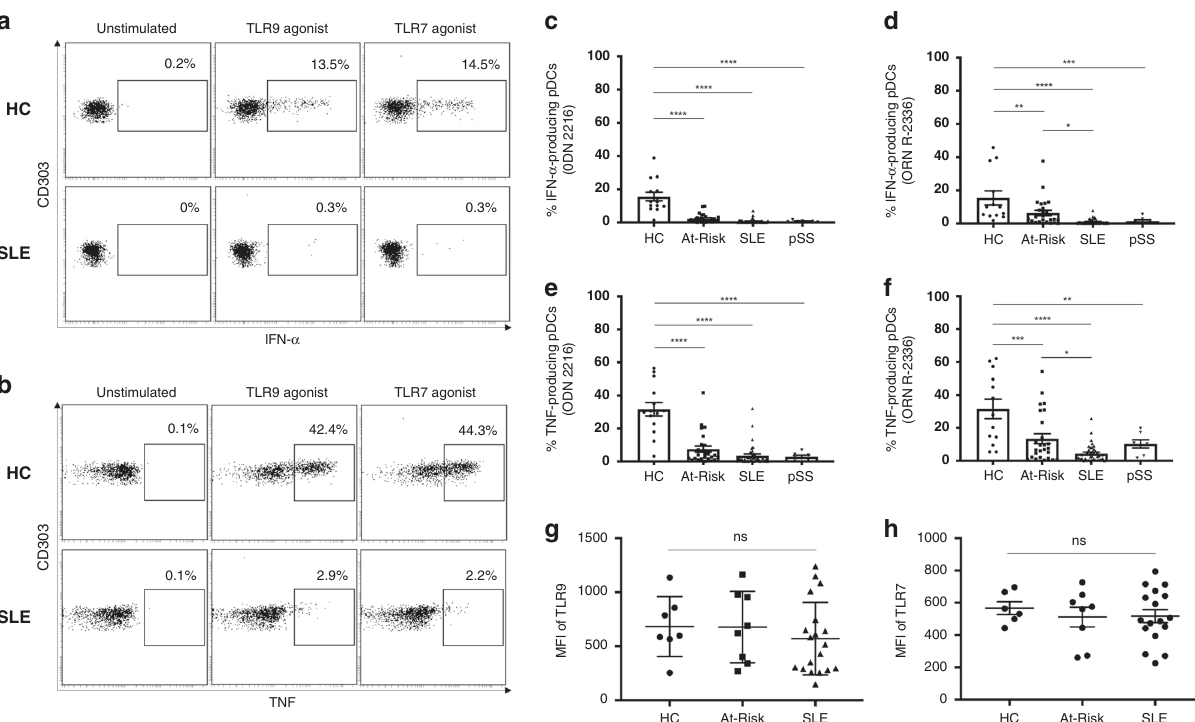
Fig. 2 TLR-stimulated pDCs produce less IFN- α and TNF in autoimmunity. a , b Freshly isolated PBMCs were cultured in the absence or presence of TLR9 (ODN 2216) or TLR7 (ORN R-2336) agonists for 6 h, then IFN- α and TNF production by pDCs was measured using intracellular staining. Results shown are representative of healthy control (HC) and a patient with SLE. The average percentage of IFN- α produced by TLR9-stimulated ( c ) and TLR7-stimulated ( d ) pDCs in HC ( n = 14), At-Risk ( n = 26), SLE ( n = 40), and pSS ( n = 7) patients. The average percentage of TNF produced by TLR9-stimulated ( e ) and TLR7- stimulated ( f ) pDCs in HC ( n = 14), At-Risk ( n = 26), SLE ( n = 40), and pSS ( n = 7) patients. g , h Intracellular expression of TLR9 and TLR7 was measured using fl ow cytometry in HC ( n = 7), At-Risk ( n = 8), and SLE ( n = 19) patients. Data are represented as mean ± SEM. * P < 0.05; ** P < 0.01; *** P < 0.001; **** P < 0.0001. Two-way ANOVA ( c – h